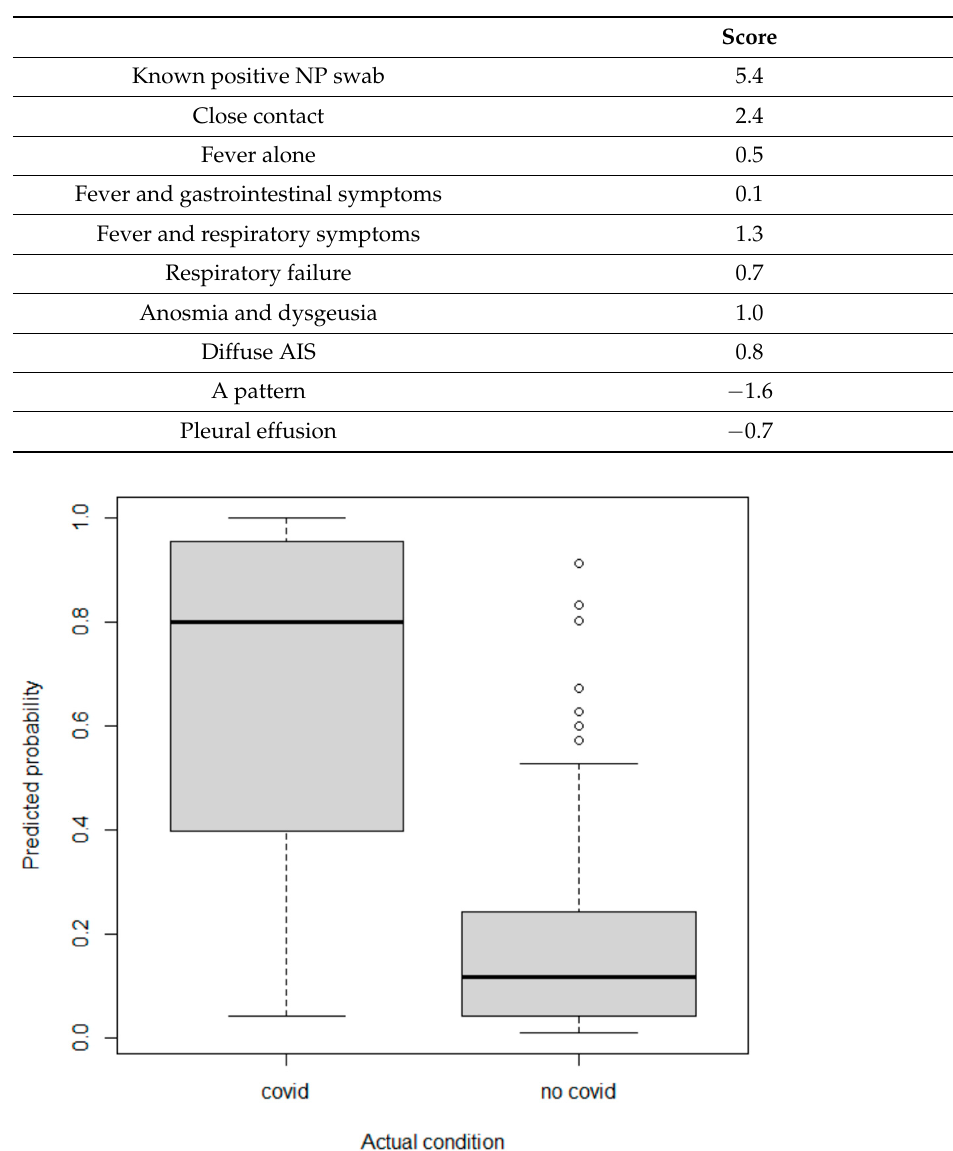
Table 5. Scores based on the logistic regression classifier. NP, nasopharyngeal. AIS, alveolar- interstitial syndrome.